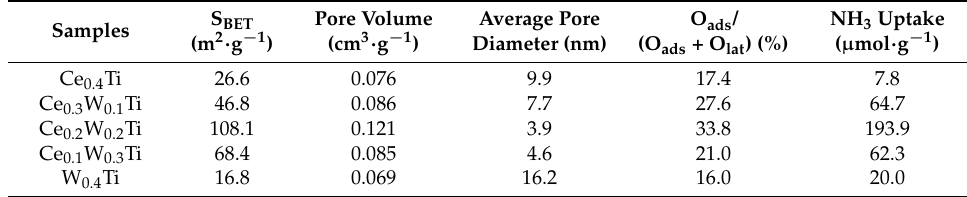
Table 1. Textural properties of the Ce-W-Ti catalysts.